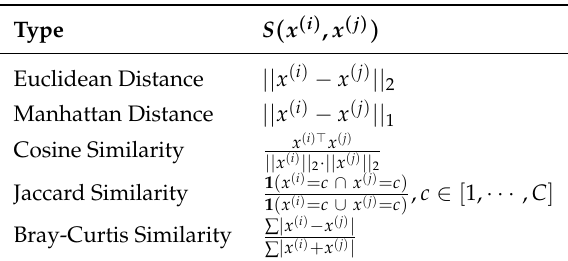
Table A3. Typical similarity formulas